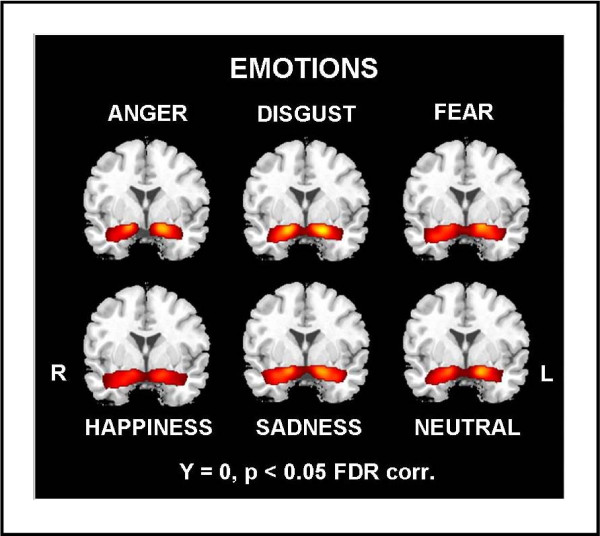
Results of whole slab random effects analysis separately for each emotion across all subjects on one coronal slice (y = 0) passing through the amygdala (p < 0.05, FDR corrected). Analysis revealed bilateral amygdala response to all emotions and neutral expressions across female and male subjects.